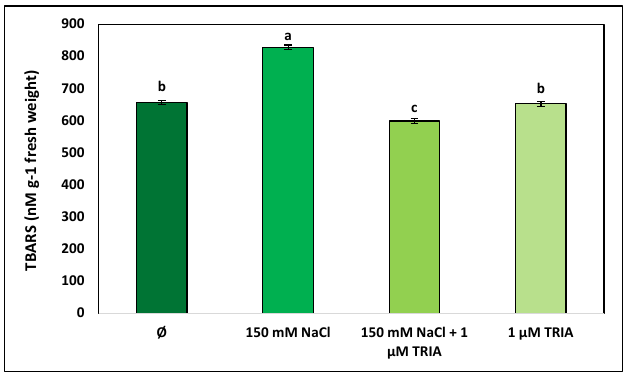
Fig. 6: Membrane lipid peroxidation assayed with the amount of thiobarbi- turic acid-reactive substances (TBARS) in roots of spinach plants exposed to salinity, with or without triacontanol (TRIA) treatment. Ø stands for the control group. Vertical bars represent ± standard er- ror from means (n=5), different letters above the columns indicate significant differences at P< 0.05 (Tukey’s HSD test)